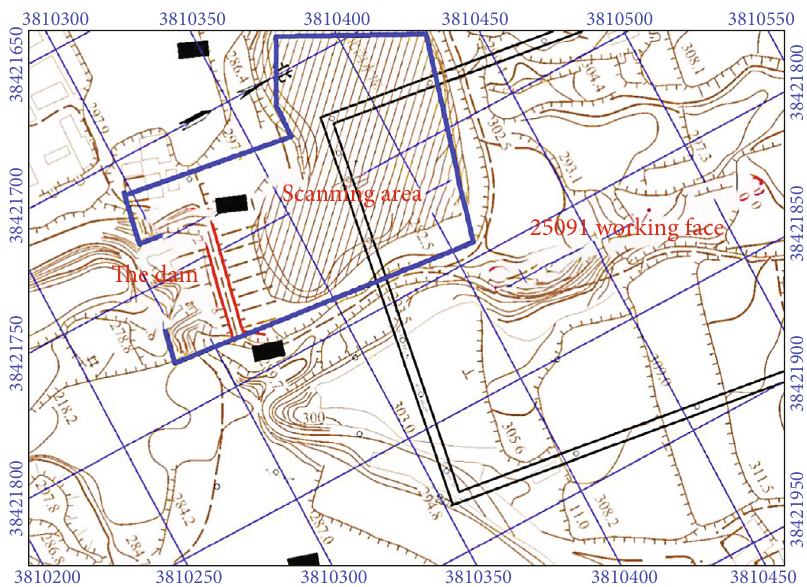
Figure 1: The location of the dam and 25091 working face.